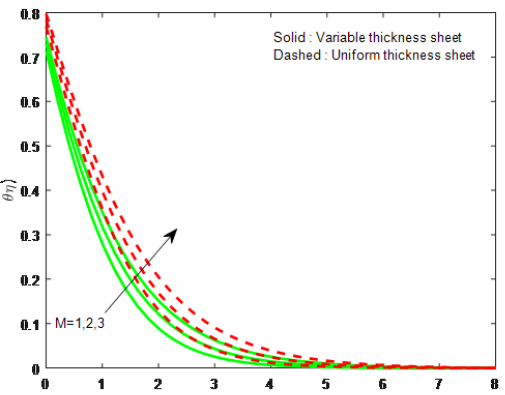
Fig. 3: Influence of M on temperature field